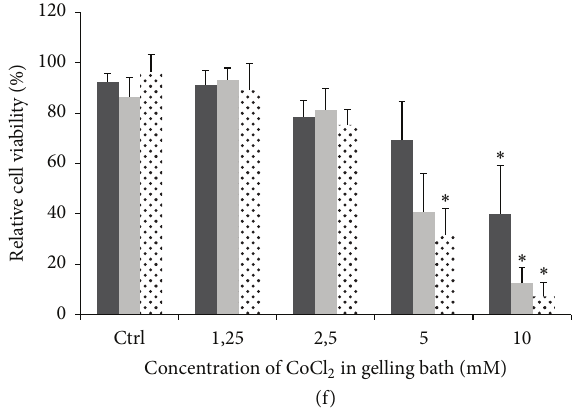
Figure 3: Live/dead (green/red) staining of hADSCs encapsulated within alginate Ca/Co beads. ((a), (a 󸀠 ), (a 󸀠󸀠 )) Control sample; ((b), (b 󸀠 ), (b 󸀠󸀠 )) Co1.25 sample; ((c), (c 󸀠 ), (c 󸀠󸀠 )) Co2.5 sample; ((d), (d 󸀠 ), (d 󸀠󸀠 )) Co5 sample; and ((e), (e 󸀠 ) (e 󸀠󸀠 )) Co10 sample. (f) Cell viability of hADSCs (live cells/live + dead cells) encapsulated within Ca/Co alginate beads. Black bar: 7 days; dark grey bar: 14 days; light grey bar: 21 days. Data are given as the means ± the standard deviation (SD) ( 𝑛 = 3 independent experiments); ∗ indicates statistical differences compared to control samples at the same time point ( 𝑃 < 0.05